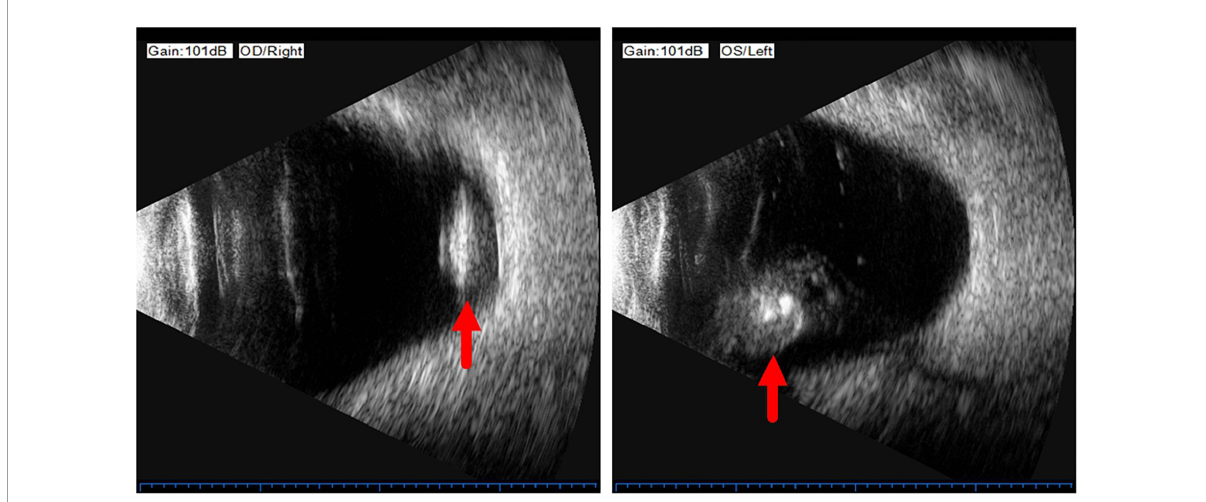
FIGURE1 B-ultrasound showed that the lenses were located in the vitreous cavity in both eyes (red arrows).